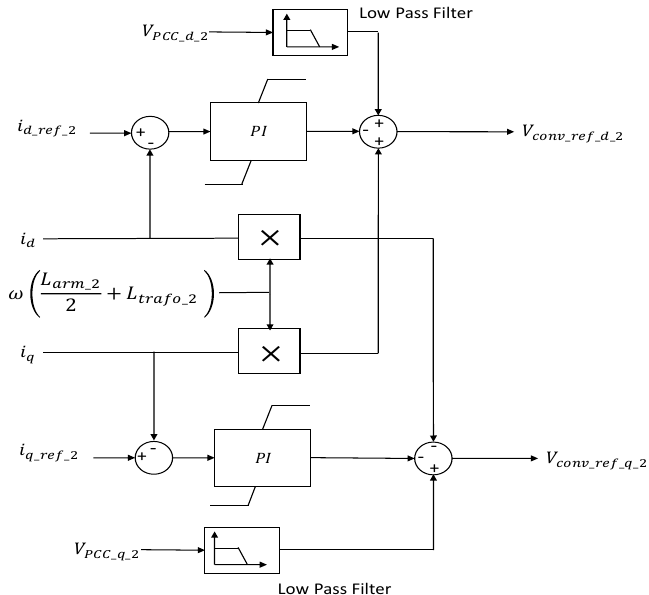
Figure 11. Inner loop control for MMC-2. The lower level controls such as circulating current suppression control, modulation and third harmonic injection are available in the average EMT model of MMC controls in [14]. They are used in both MMC-1 and MMC-2. Further, the performance of the 2 GW offshore network needs to be analyzed during steady state and dynamic conditions after scenarios are studied, as depicted in Figure 12, in the following section.